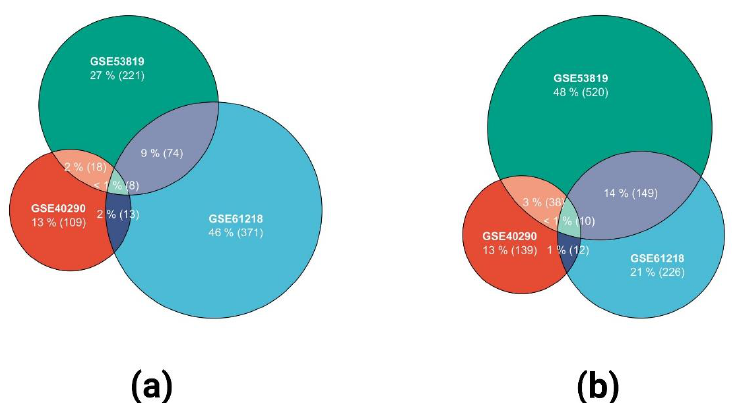
Figure 3. Wayne diagram of the upregulated DEGs ( a ) and downregulated DEGs ( b ).